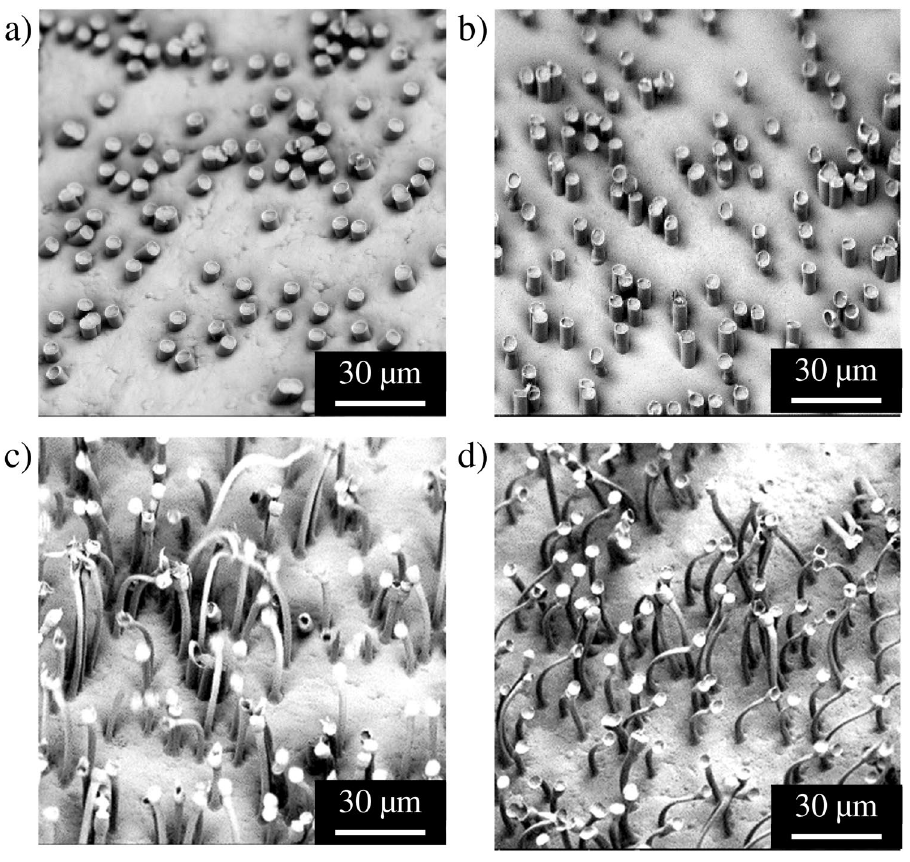
Figure 4. SEM images of a HDPE sample structured through contact with membranes with a pore diameter of 5 µm; contact temperature: T = 140 °C; contact times: contact times: ( a ) 30 s, ( b ) 60 s, ( c ) 300 s and ( d ) 600